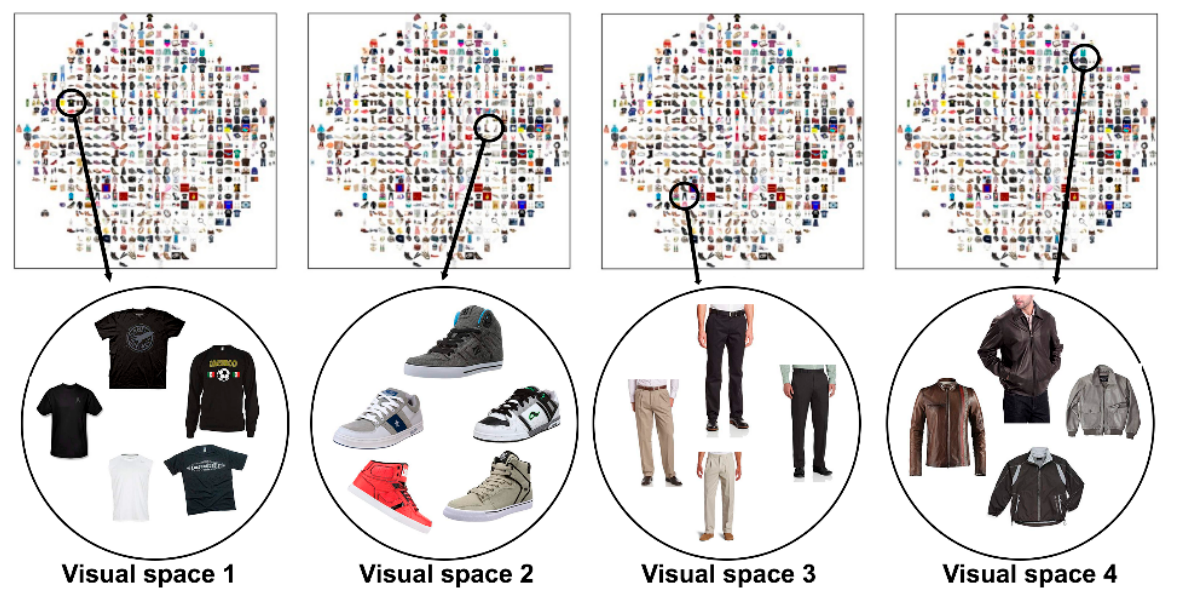
Figure 9. An illustration that summarizes the t-SNE representation of the Amazon-Fashion dataset, which reduces the data to two dimensions, has revealed four distinct visual spaces, each representing a single class.